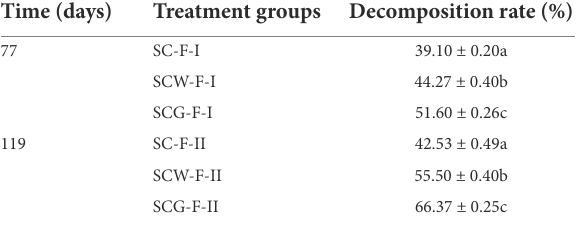
TABLE 3 The decomposition rate of cornstalk under different